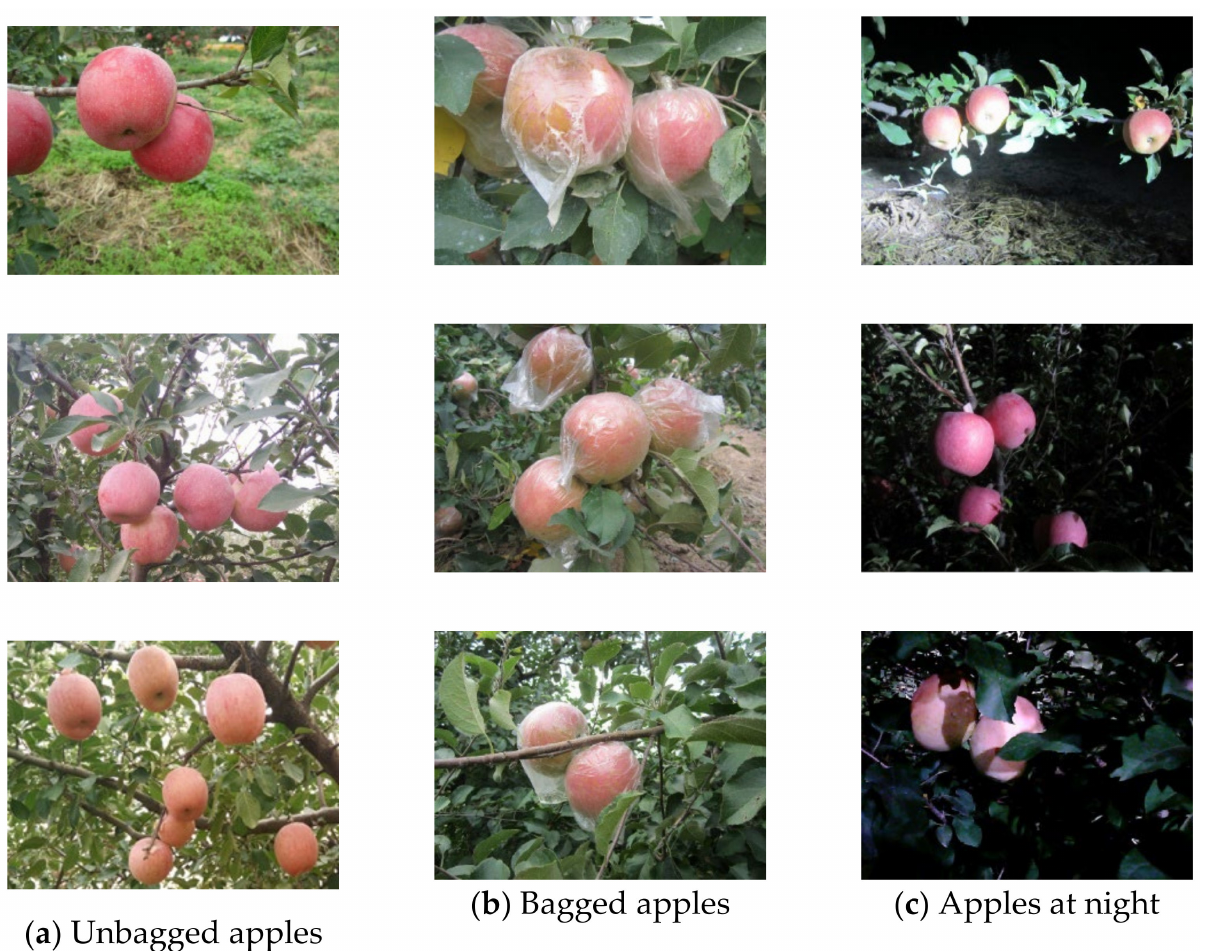
Figure 1. Apple image in natural